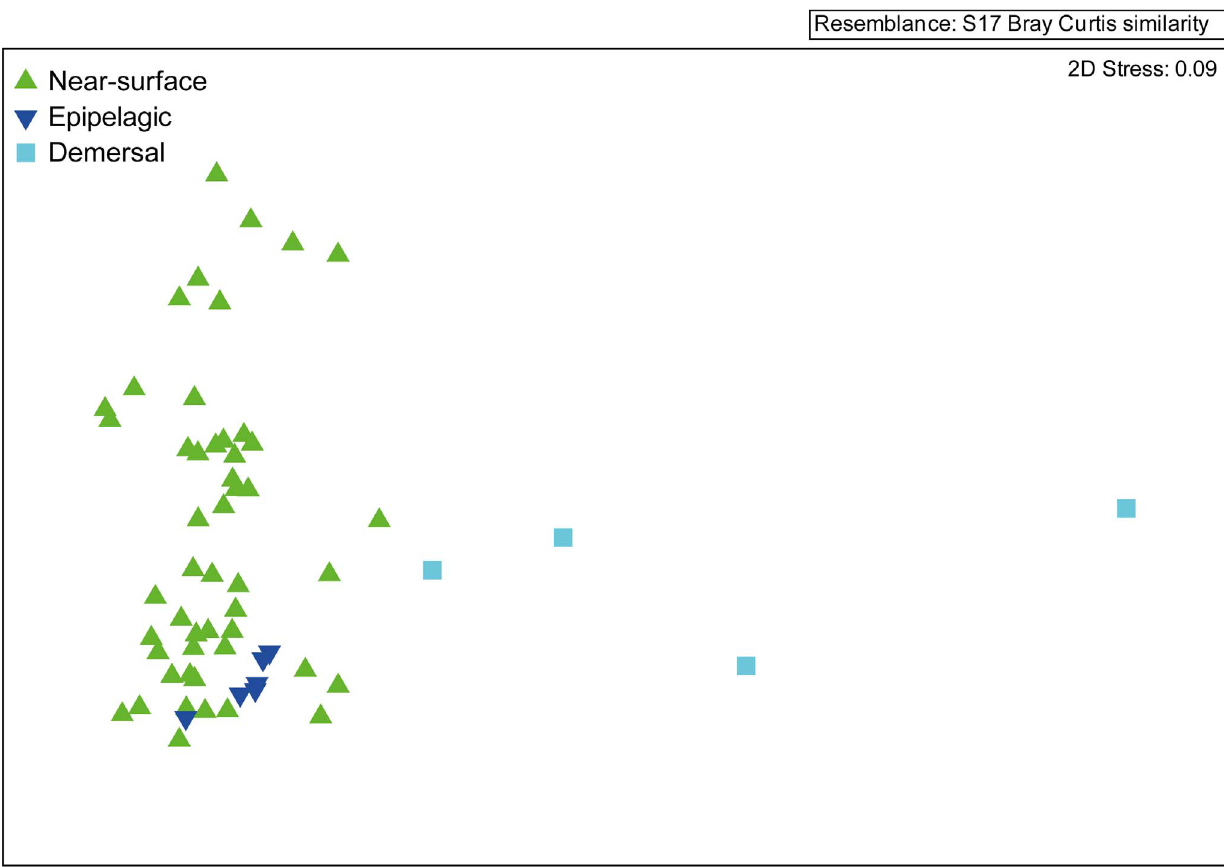
Figure 3. Comparison of zooplankton fatty acid (FA) profiles. Multi-dimensional scaling ordinations of zooplankton groups from different sampling areas collected in eastern Australia, considering all FA . 0.2% (n=50).